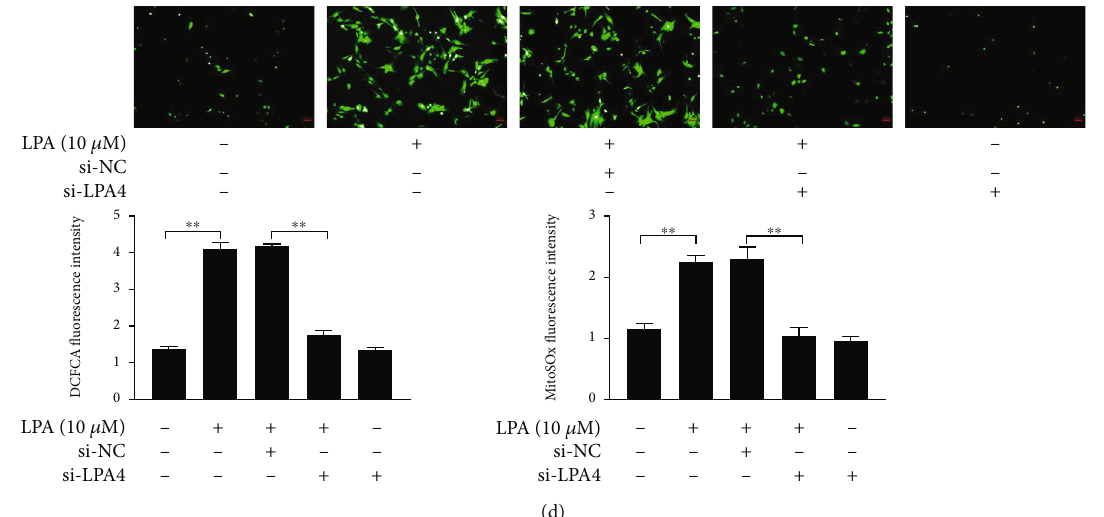
Figure 6: LPA4 mediates LPA-induced spinal cord neuron apoptosis, DNA damage, and oxidative stress. (a, c) The expression of LPA4, DNA damage-related proteins in spinal cord neurons were measured by western blotting. (b) The apoptotic ratio was detected by fl ow cytometry. (d) Quantity analysis of intensity of the DCFDA staining and MitoSOx staining. Asterisks indicate statistical signi fi cance ( ∗ p < 0 : 05 , ∗∗ p < 0 : 01